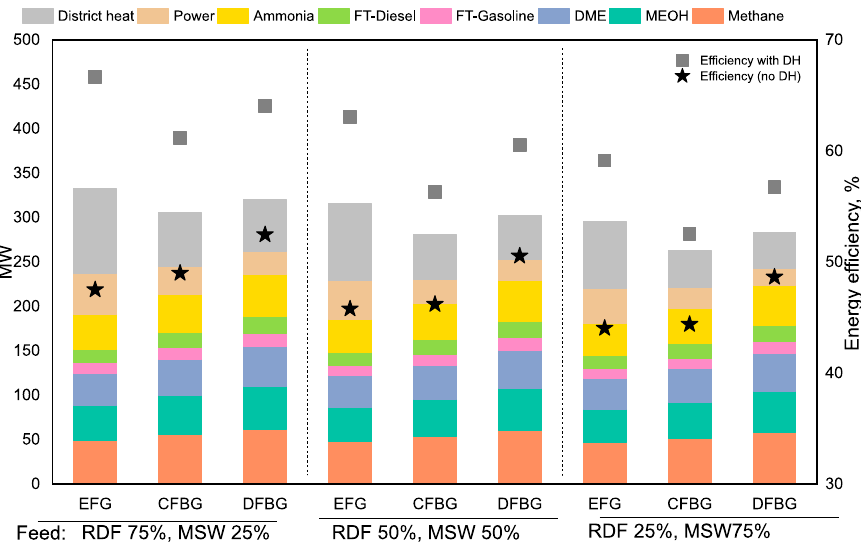
Figure 15. Power, biofuels and heat distribution for gasification of mixed RDF and MSW feed in the three gasifiers (EFG, CFBG and DFBG). Total feed = 500 MW; an equal amount of syngas was transferred for biofuels and power production in each case.